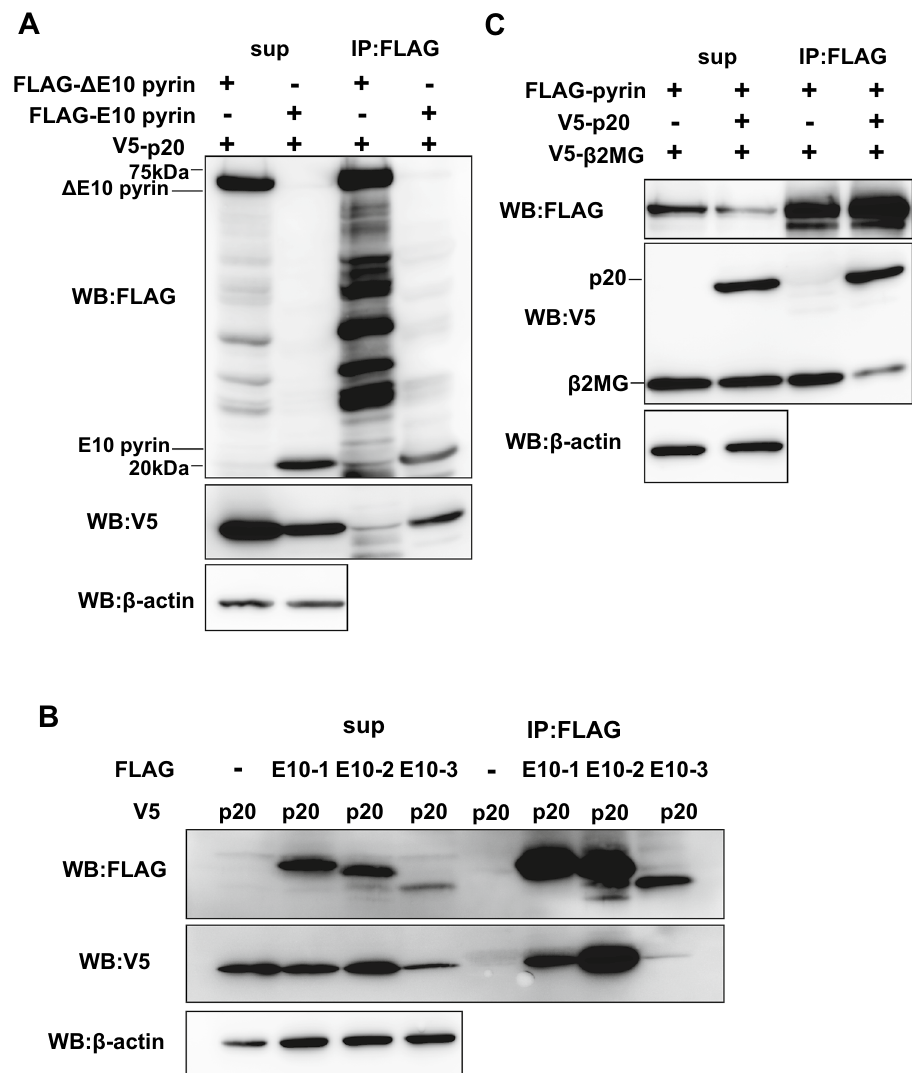
Figure 6. Caspase-1 p20 subunit interacts with pyrin in a manner that competes with β2MG. ( A ) FLAG-Δ10 pyrin and FLAG-E10 pyrin were expressed with V5-tagged caspase-1 p20 subunit (V5-p20) respectively in Lenti-X 293T cells. They were lysed with lysis buffer and subjected to co-immunoprecipitation analysis using FLAG Ab conjugated agarose. V5-p20 binds to pyrin exon10 region. ( B ) Lenti-X 293T cells expressing each pyrin E10-1, E10-2 and E10-3 region with V5-p20 were lysed with lysis buffer. Co-immunoprecipitation analysis using FLAG Ab conjugated agarose reveals caspase-1 p20 binds to the pyrin E10-2 region, the same as β2MG. ( C ) Lenti-X 293T cells expressing FLAG-pyrin and V5-β2MG with or without V5-p20 were lysed with lysis buffer and subjected to co-immunoprecipitation analysis using FLAG Ab conjugated agarose. Co-immunoprecipitation analysis reveals caspase-1 p20 subunit binds to pyrin competitively with β2MG and inhibits pyrin–β2MG